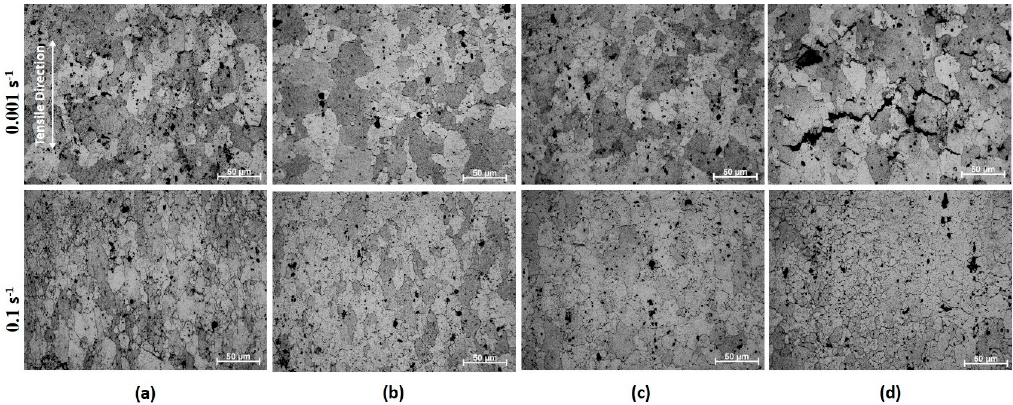
Figure 5. Optical micrographs of ( a ) as-received (AA 7075-T6 aluminum alloy), ( b ) the solution heat-treated material, ( c ) sample processed in a die with a temperature of 24 °C, and ( d ) sample processed in a die with a temperature of 350 °C. All micrographs highlight microstructure evolution after tensile tests at the temperature of 350 °C and strain rates of 0.001 s − 1 (upper row) and 0.1 s − 1 (lower row).